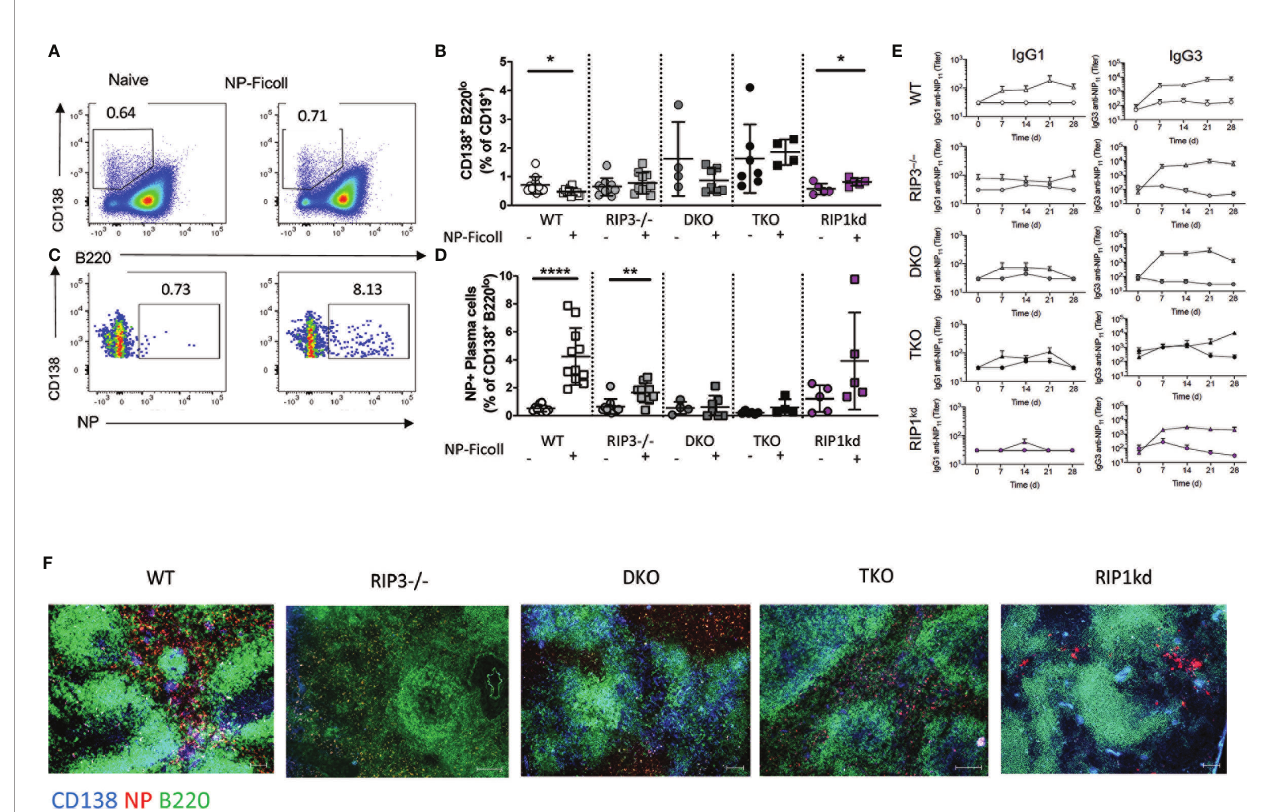
FIGURE 6 | T-independent B cell responses require Casp8. Representative fl ow cytometry plots demonstrate gating for frequency of splenic CD19 + B cells which are plasma cells (PC; CD138 + B220 - IgM - IgD - ) in naïve mice compared to mice immunized with 30 m g of NP-Ficoll 28 days previously and 17 days after a boost (A) . Total PC B cell frequencies quanti fi ed for naïve or immunized C57BL/6 WT, RIP3-/-, DKO, TKO and RIP1 kd mice (B) . Flow cytometry plots demonstrating gating for frequency of splenic CD19+ B cells which are antigen speci fi c (NP+) PCs (C) . Antigen-speci fi c PC B cell frequencies quanti fi ed for naïve or immunized C57BL/6, RIP3-/-, DKO, TKO and RIP1 kd mice (D) . ELISA detects NP speci fi c IgG1 and IgG3 antibody titers in serum of C57BL/6 WT, RIP3-/-, DKO, TKO and RIP1 kd mice weekly for 28 days after immunization with 30 m g of NP-Ficoll (E) Spleens from NP-Ficoll immunized mice were labeled with immuno fl uorescent antibodies to identify B cell zone (anti-B220; green), PCs (anti-CD138; blue), and NP-speci fi c B cells (NP-PE; red) in C57BL/6 WT, RI3-/-, DKO, TKO and RIP1 kd mice (F) . Data is representative (A, C, F) or a pool (B, D, E) of least two independent experiments, 3-6 mice per group. Each symbol identi fi es an individual mouse. *p ≤ 0.05, **p ≤ 0.01, ***p ≤ 0.0001 (One-way ANOVA) Scale bar = 200 m m. Represents 3-4 images per slide, 3-4 sections per mouse, and 3 mice per group (F)